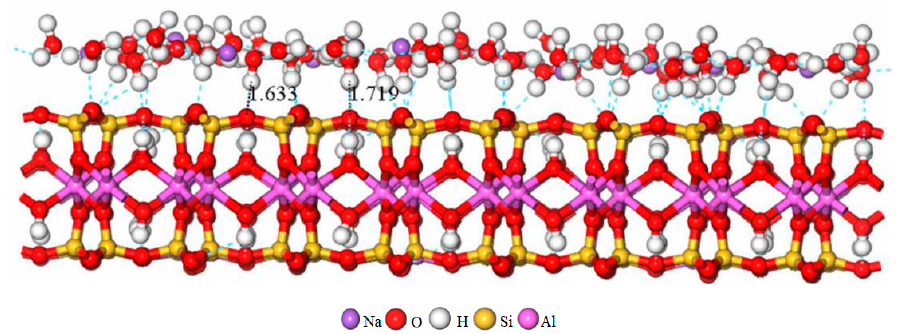
Figure 8. Hydrogen bonds are formed between H in H 2 O and O in tetrahedral surfaces at the distance of 1.676 ± 0.043 Å in Na-MT4 0-11 .